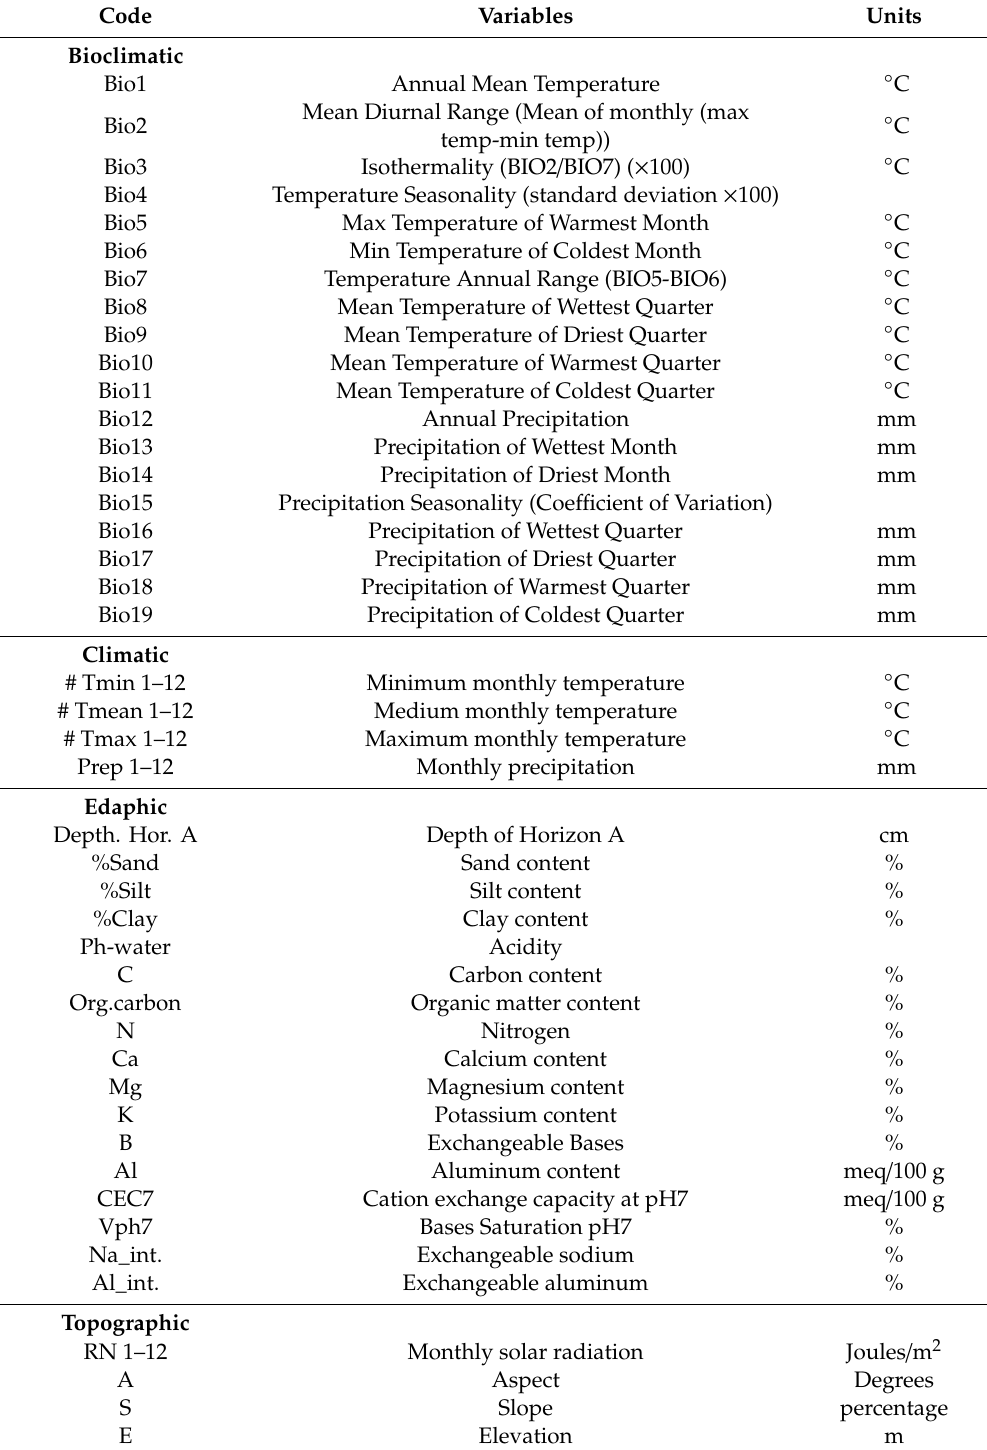
Table 1. Environmental data used to predict the occurrence of habitat suitable for Eucalyptus dunnii and E. grandis in Uruguay. The variables selected to predict the occurrence of both species appear in bold